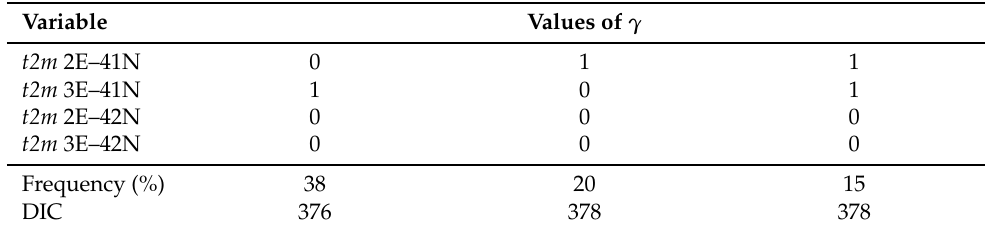
Table 4. Values of γ with a frequency higher than 5% in the MCMC. Bottom: frequency of appearance and DIC. Barcelona